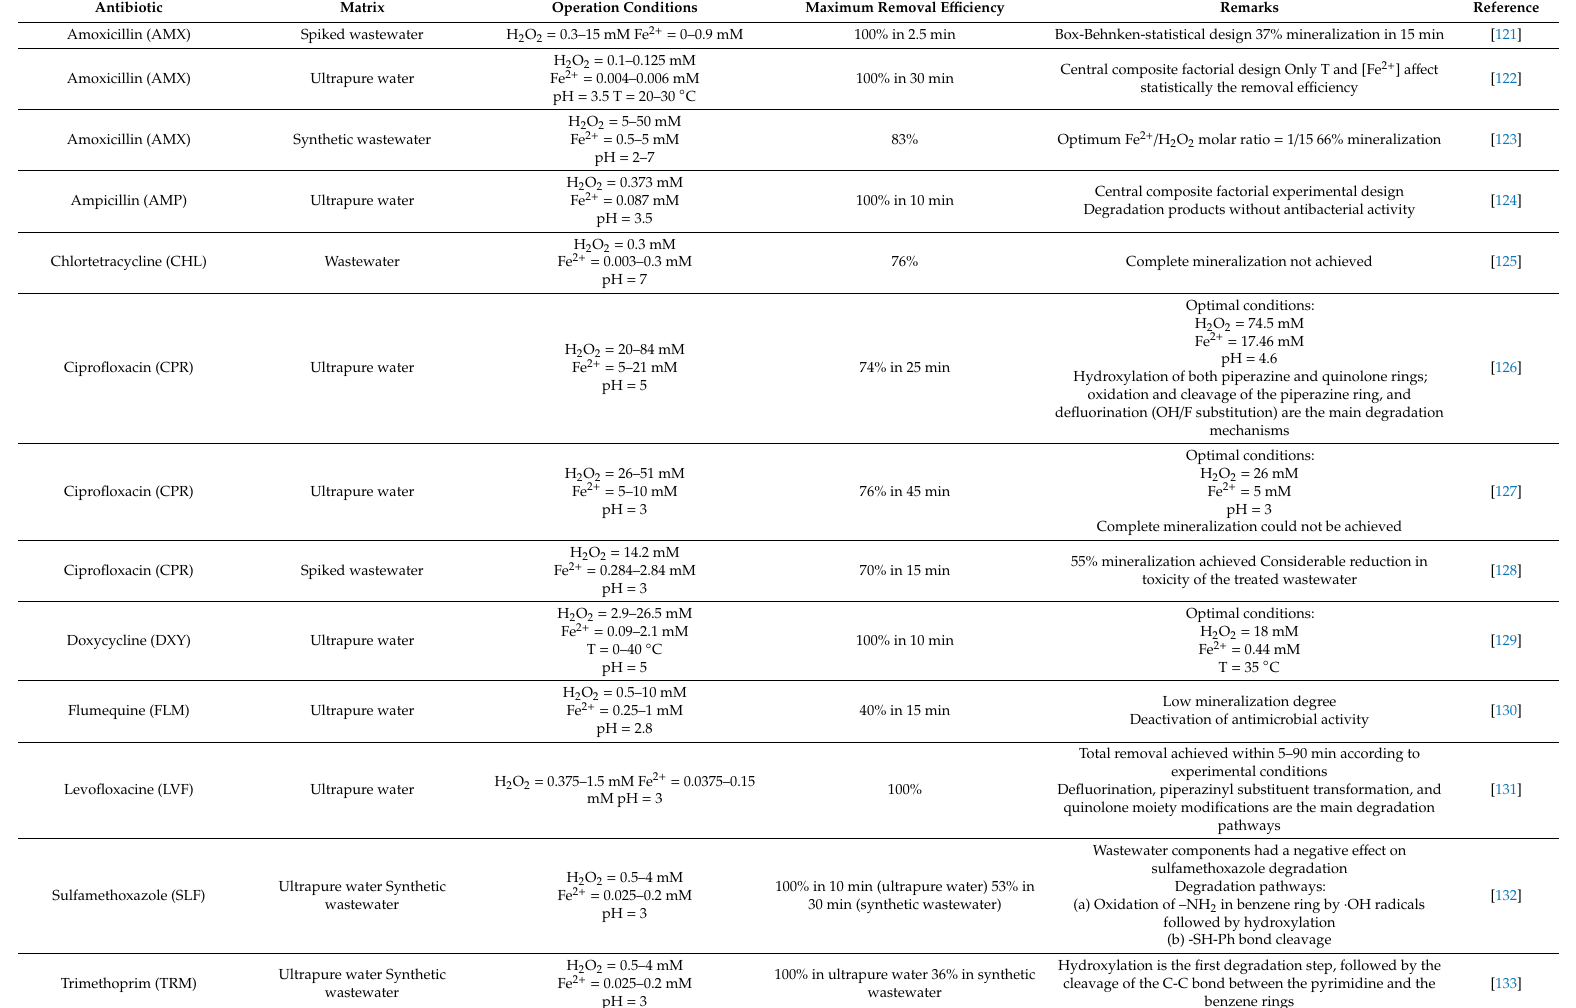
Table 10. Removal e ffi ciency of antibiotics in waters by the Fenton